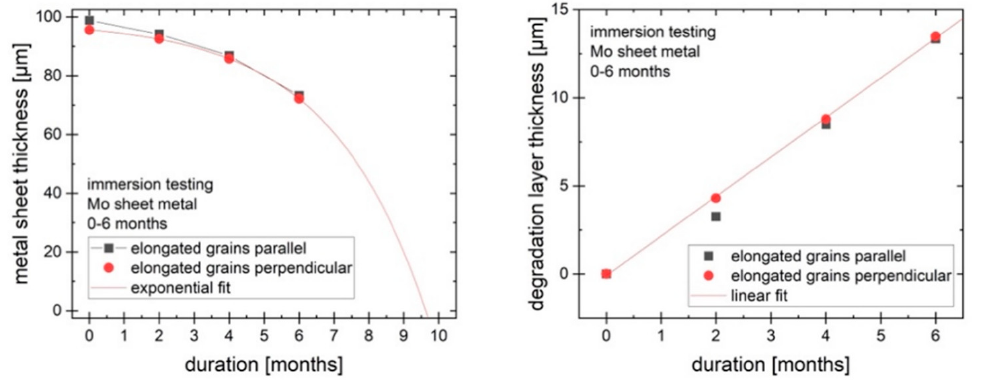
Figure 8. Metallic and degradation product layer